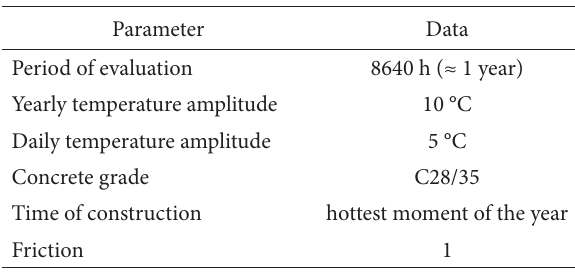
Fig. 4. Different expressions of the relaxation factor Table 2. Constant parameters in the